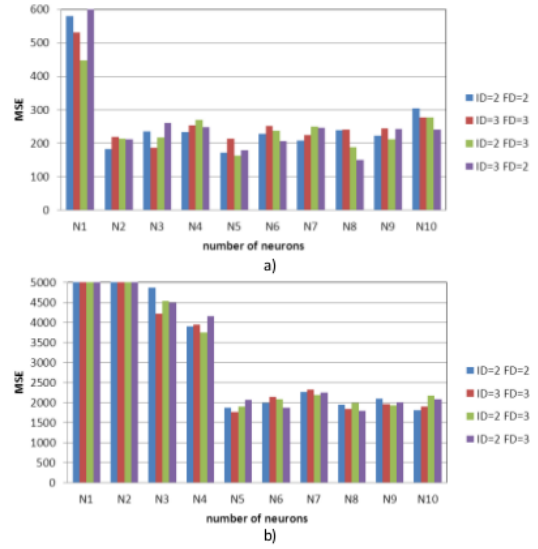
Figure 4: Neural network structure optimization results a) tempera- ture, b)